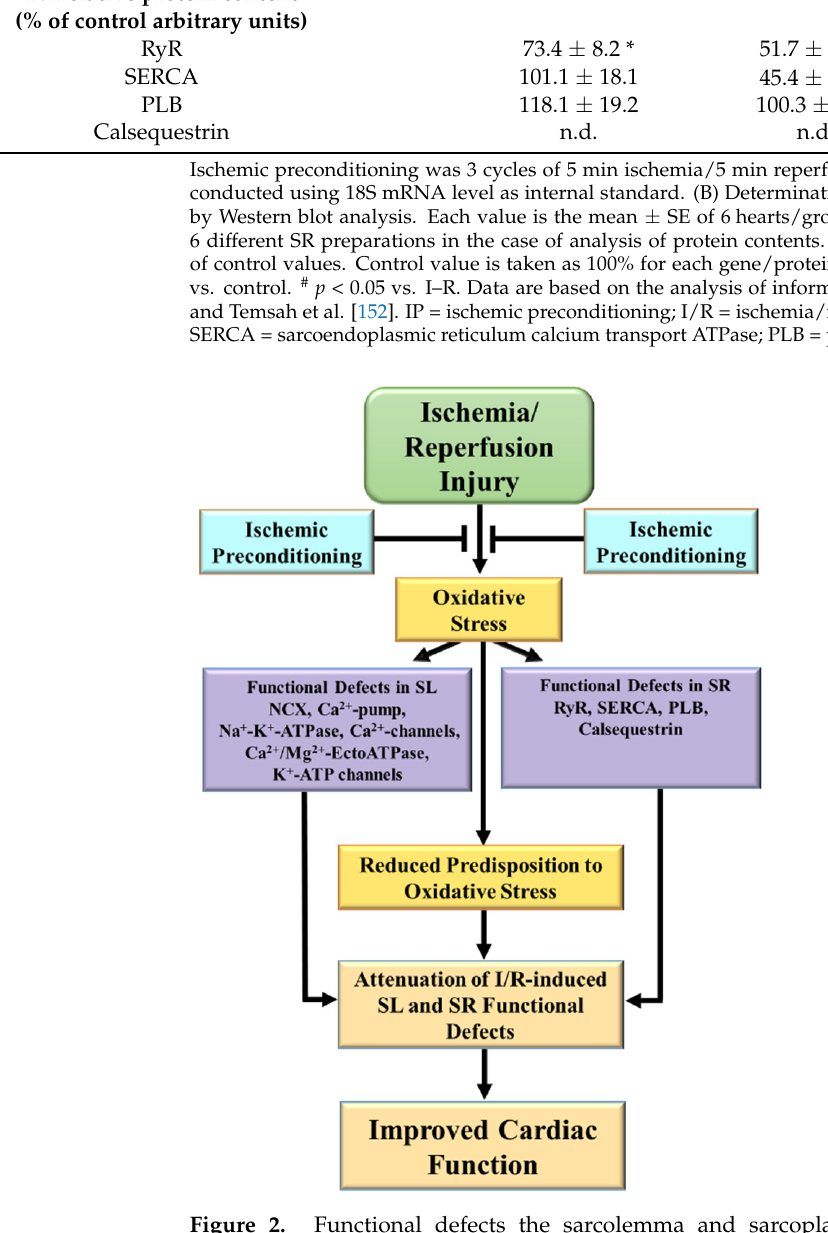
Figure 2. Functional defects the sarcolemma and sarcoplasmic reticulum membrane compartments due to ischemia/reperfusion and protective effects of ischemic preconditioning. SL = sarcolemma; SR = sarcoplasmic reticulum; NCX = Na + -Ca 2+ -exchanger; RyR = ryanodine receptor, SERCA = sarcoendoplasmic reticulum calcium transport ATPase; PLB = phospholamban; I–R = ischemia–reperfusion.